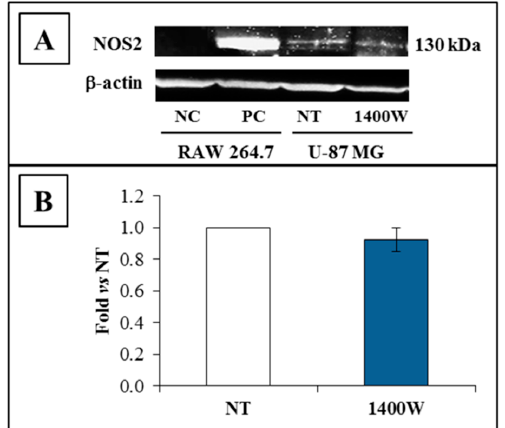
Figure 2. NOS2 protein expression of the adherent U-87 MG glioblastoma cell line. ( A ) Representative Western blot of NOS2 and β -actin. U-87 MG cells were cultured and treated or not with 1400W (100 µ M) as described for 24 h. NC (negative control): Untreated RAW 264.7; PC (positive control): RAW 264.7 treated with LPS (Lipopolysaccharide) (1 μ g/mL) and IFN- γ (Interferon- γ ) (100 ng/mL) for 24 h. ( B ) Quantification analysis of blots by densitometry is expressed as fold increase vs. NT. The results from three independent experiments in duplicate are presented and expressed as mean ±